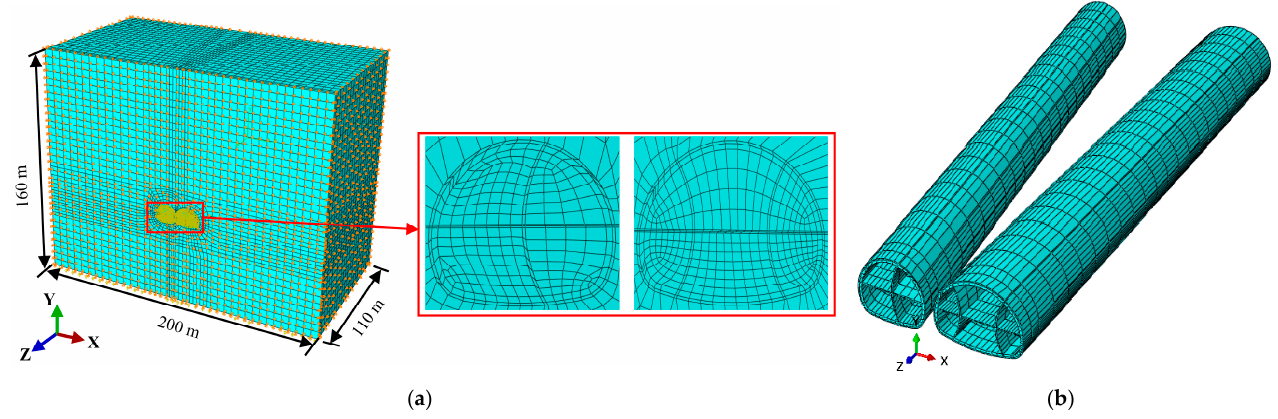
Figure 4. Numerical calculation model: ( a ) overall numerical model; ( b ) tunnel lining.